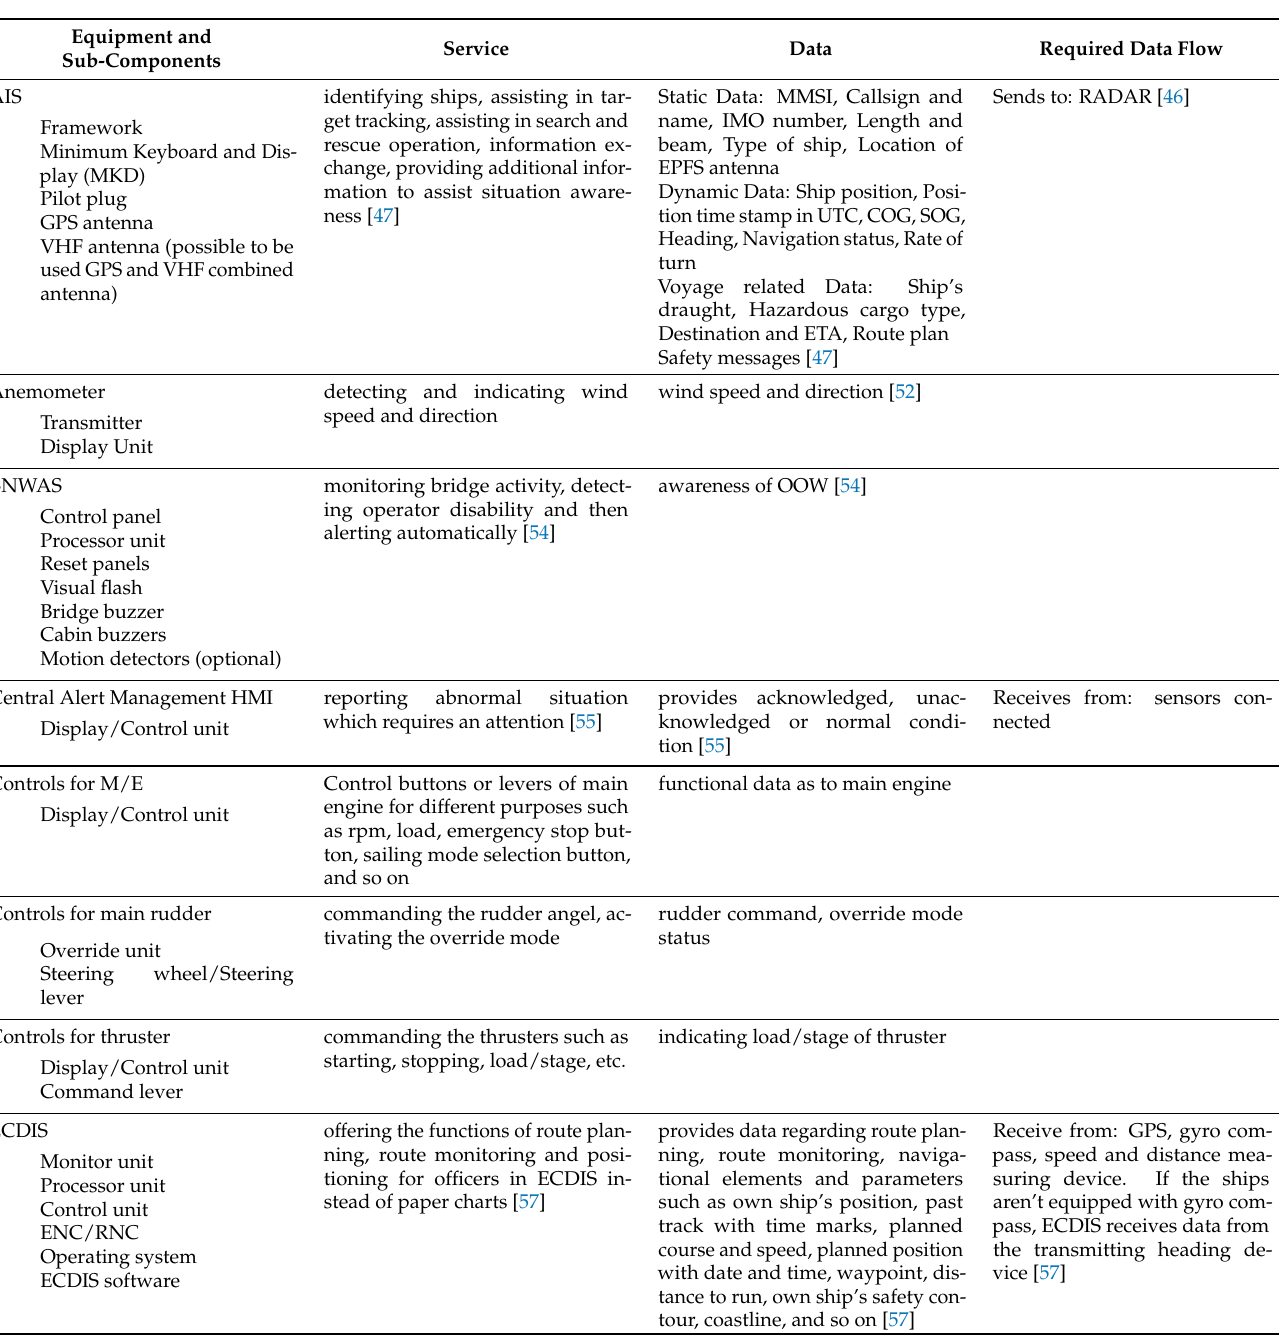
Table A1. Selected equipment with details of sub-components, functions, and